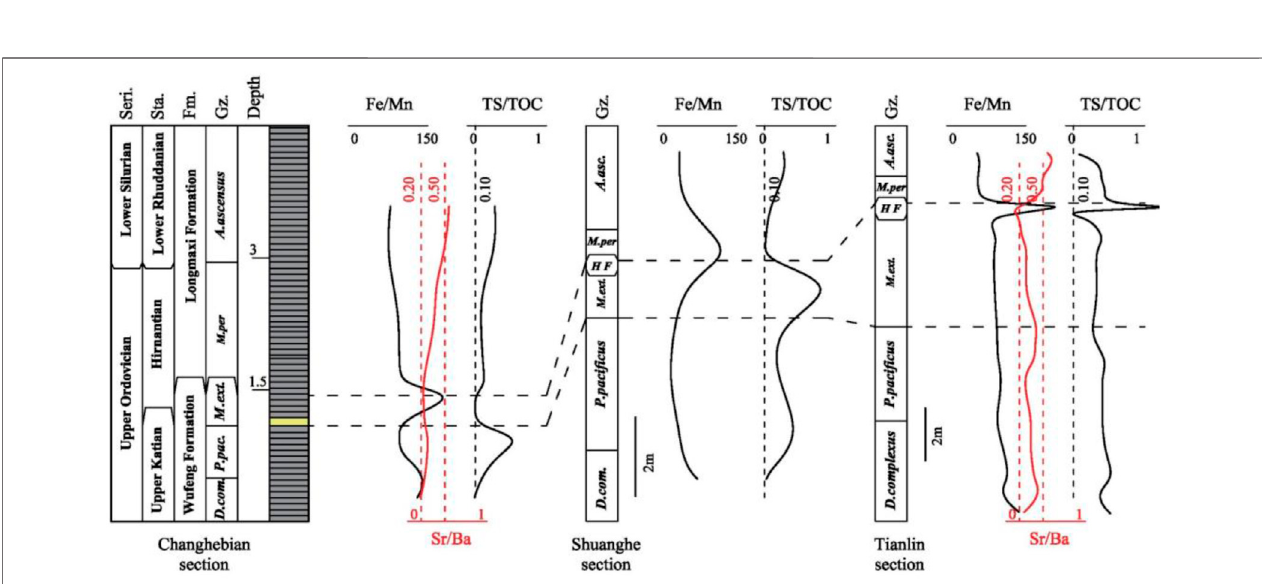
FIGURE8| Comparisonofpaleo-waterdepthandpaleosalinityforthestudysections.ThedataontheShuanghesectionarefromLietal.(2017).Abbreviationsas in Figure 1 . Red and black vertical dashed lines represent thresholds for proxies, as shown in the text.